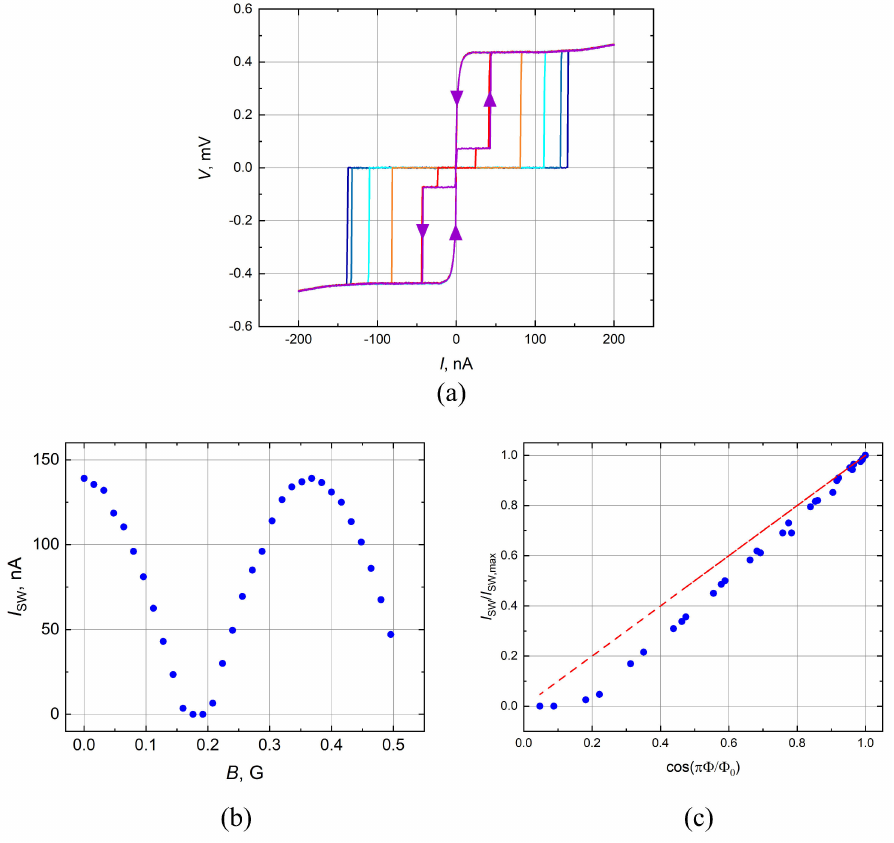
Figure 4. ( a ) Current-voltage characteristics of a single SQUID formed by JJs with E J = 2.4 K (sample 2 in Table 1) measured at different values of Φ / Φ 0 = 0,0.08,0.17,0.25,0.37,0.5. A sub-gap voltage plateau at V ≈ 75 µ V appears at Φ > 0.35 Φ 0 . For different samples the sub-gap voltage plateau was observed at V = 40–200 µ V. ( b ) The dependence of I SW on the magnetic field B . ( c ) The measured I SW ( Φ ) / I SW ( Φ = 0 ) as a function of cos ( π Φ / Φ 0 ) . The dashed line corresponds to the dependence I SW ∝ cos ( π Φ / Φ 0 )